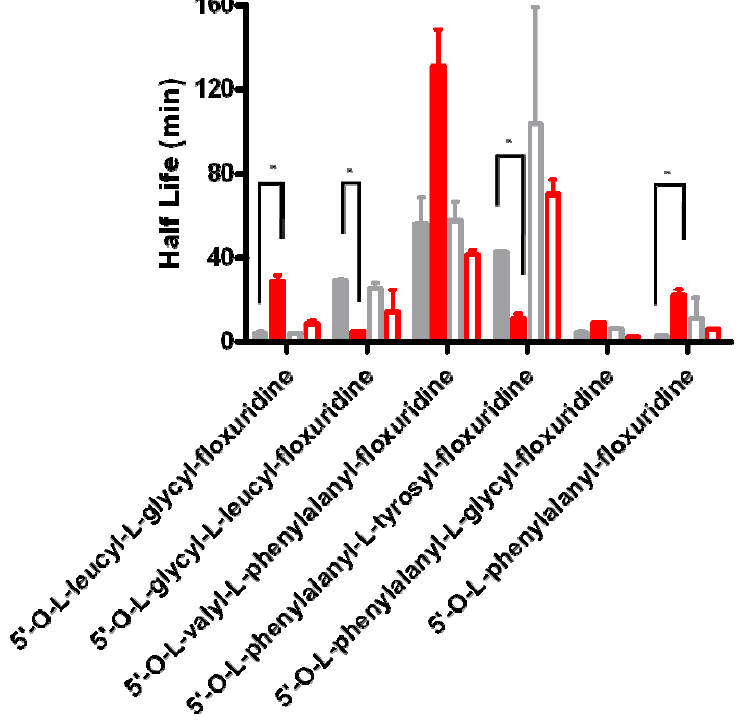
Figure 2. The difference of prodrug stability in the cytosolic fraction of cell homogenate and in whole cell homogenate of Capan-2 and Caco-2 cells. Gray bars represent the prodrug stability in whole cell homogenate and red bars represent the prodrug stability in the cytosolic fraction of cell homogenate. Closed bars represent the prodrug stability in Capan-2 cells and open bars represent the prodrug stability in Caco-2 cells. Values presented are the mean ± s.d., n = 4, (* p < 0.01; t